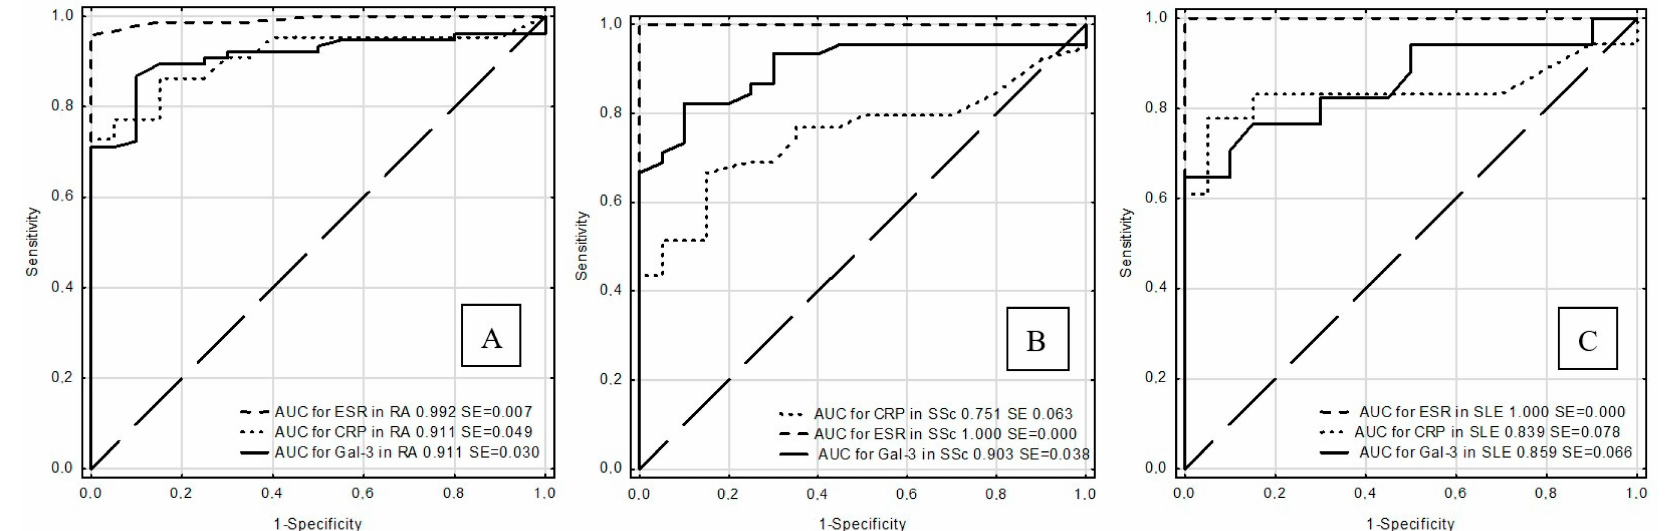
Figure 1. ROC curves for galectin-3, CRP, and ESR in rheumatoid arthritis (RA) ( A ), systemic sclerosis (SSc) ( B ), and systemic lupus erythematosus (SLE) ( C ).